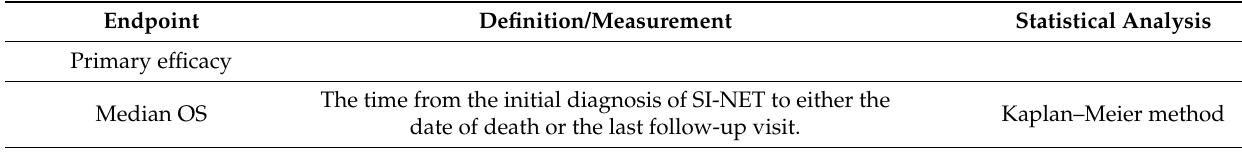
Table 1. Summary of the primary and secondary efficacy endpoints for the patients with